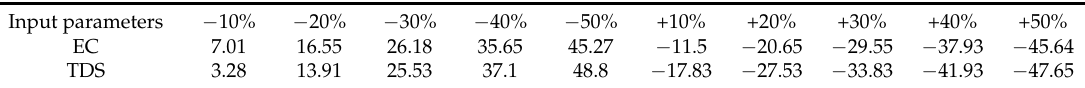
Table 6. Sensitivity analysis of input parameters on EC and TDS in Abu-Ziriq Marsh using ANFIS